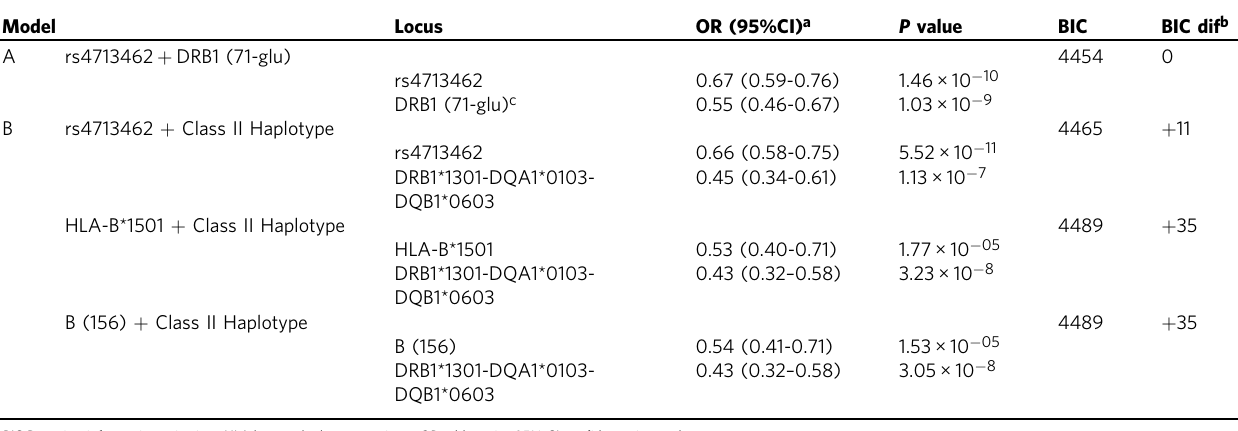
Table 3 HLA alleles, SNP and amino acids contained in the best models obtained from HPV( + )OPC analyses as judged by the BIC criterion.